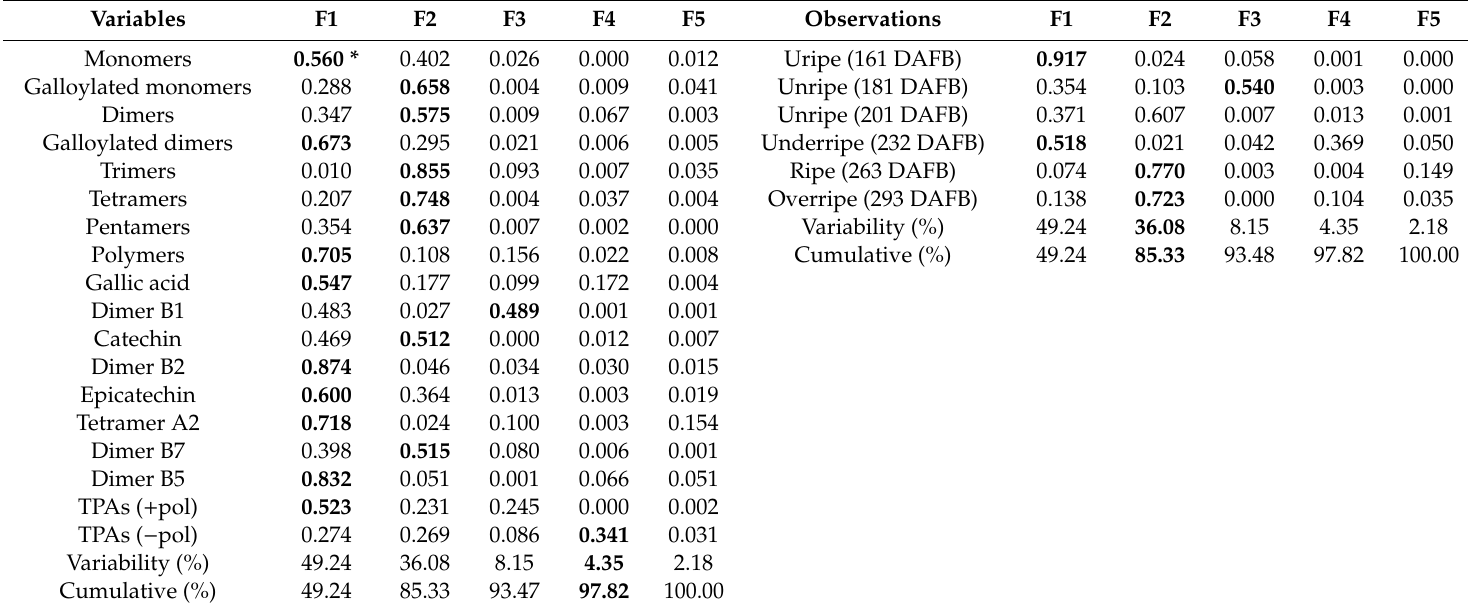
Table 6. Matrix of dominant rotated factor (F) loadings on proanthocyanidins (%, fresh weight) in the seed in black ‘Isabel’ grape during berry development. Variables